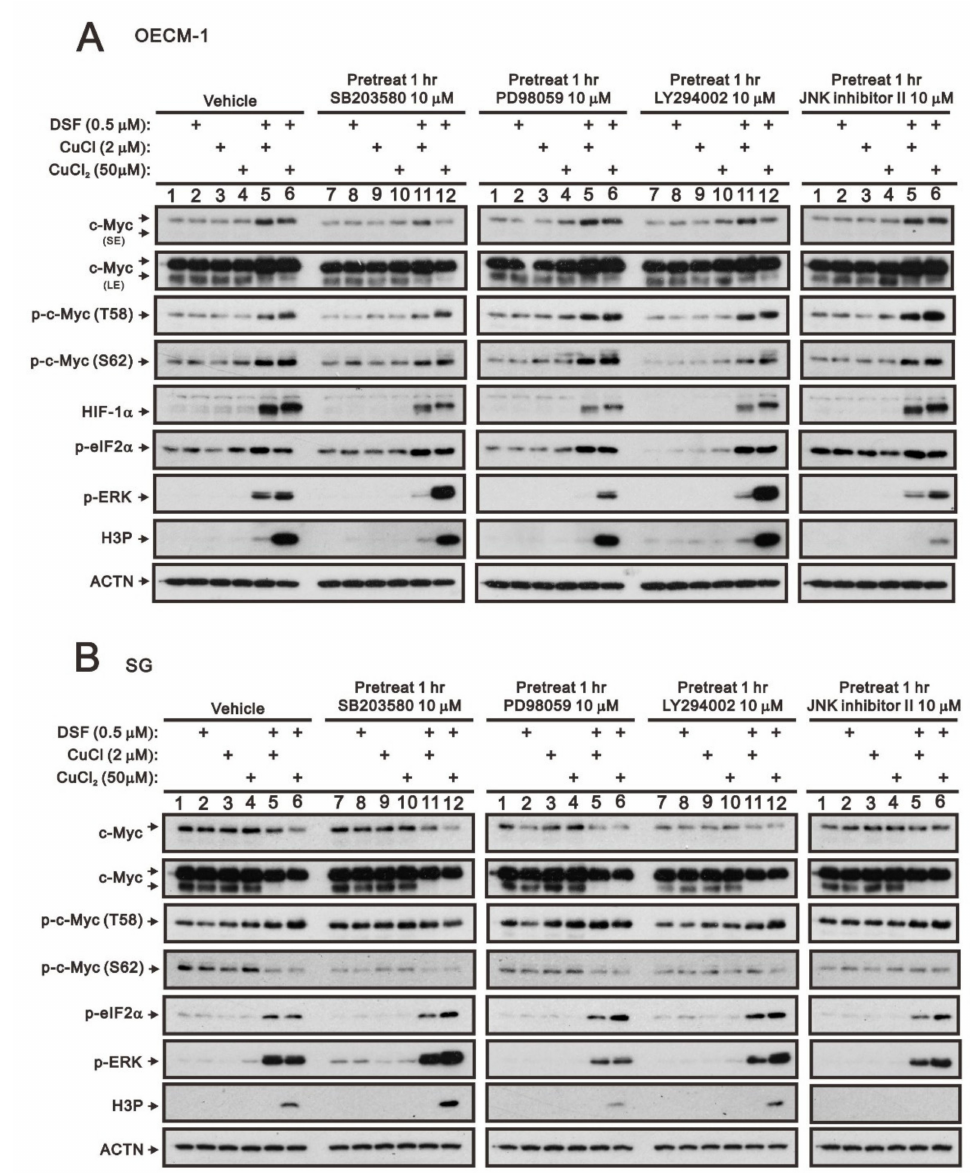
Figure 2. The effects of DSF, copper ions, and DSF/copper complexes on the signaling pathways involved in the c-Myc and HIF-1 α proteins in OECM-1 and SG cells. ( A ) OECM-1 and ( B ) SG cells were pretreated with the indicated 10 µ M of signaling inhibitors for 1 h and then treated with 2 µ M of CuCl or 50 µ M of CuCl 2 plus 0.5 µ M of DSF for 2 h (added indicated drugs labeled with +). The cell lysates were subjected to Western blot analysis using antibodies against the indicated proteins. ACTN was a loading protein control. The results are representative of three independent